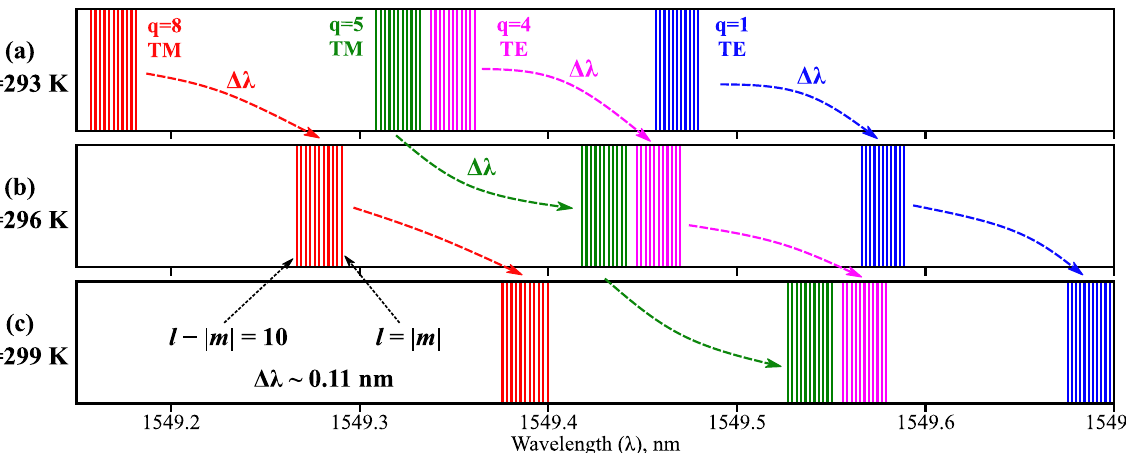
Figure 4. WGM resonant wavelengths (marked with vertical lines) calculated at different ambient temperatures: ( a ) T = 293 K, ( b ) T = 296 K, ( c ) T = 299 K. Modes with identical radial indices q and polarizations are denoted by lines of the same color; arrows indicate mode drift with changes in T . Data are shown for As 2 S 3 microsphere with R 0 = 100 μ m, 1 ≤ q ≤ 10, 0 ≤ l − | m | ≤ 10; shape deformation parameter η = 7 × 10 − 4 . Total wavelength range is roughly a third of the fundamental WGM distance.